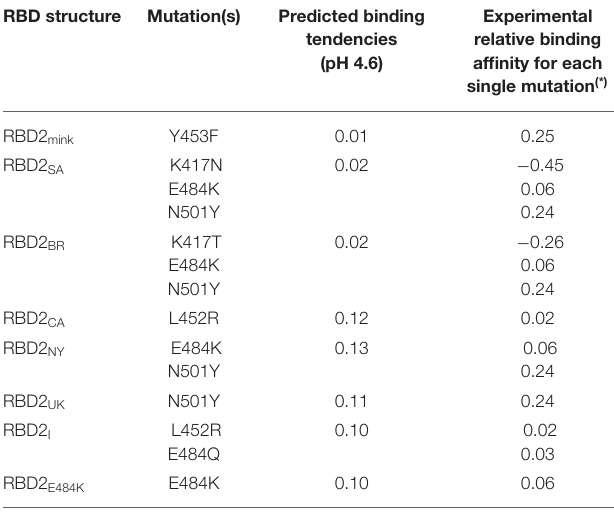
TABLE 1 | Estimated binding affinities for RBD–ACE2 interactions. RBD